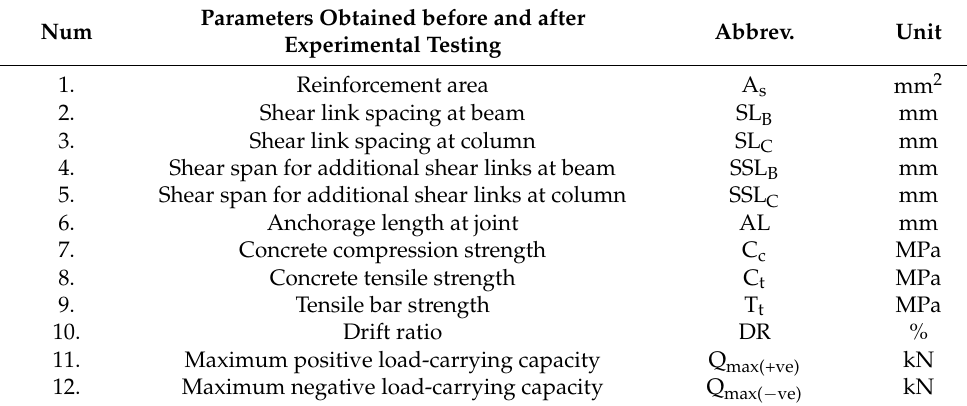
Figure 3. Lateral cyclic loading history for RC beam-column joint specimen. Table 2. List of data opted as potential input parameters for modeling